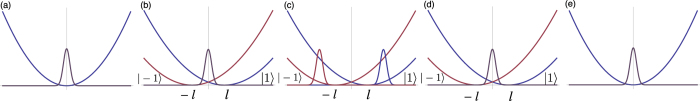
Illustration of the splitting protocol for gravimetry.Shown are the spin dependent harmonic trapping potentials along the  direction and the one dimensional spatial wave function for the resonator as a function of z. This protocol is repeated M(K, k) times for each value of the qubit resonator coupling λk = 2kλ0, for k = 0, … K where λ0 is a minimal value of the coupling. (a) At t < 0 the resonator is prepared in the ground motional state with an rms width z0 and frequency ω. The qubit is not coupled to the resonator (λk = 0). (b) At time t = 0 the qubit in prepared in the superposition state |+x〉 and the interaction λk is turned on. The trapping potential is now state dependent with minima located at ±l = ±λkz0/ω. (c) After half an oscillation period, the state dependent motional wave packets are maximally separated by a distance 4l. (d) After a full oscillation period, the wave packets recombine, localised at the origin with the accumulated gravitationally induced phase ϕk mapped onto the qubit. (e) The interaction is turned off and the qubit is measured. For  rounds the qubit is measured in the basis {|±x〉} basis and for the other  rounds in the basis  providing an estimate  of the phase ϕk. After the last stage the resonator returns to a ground state of the trapping potential.